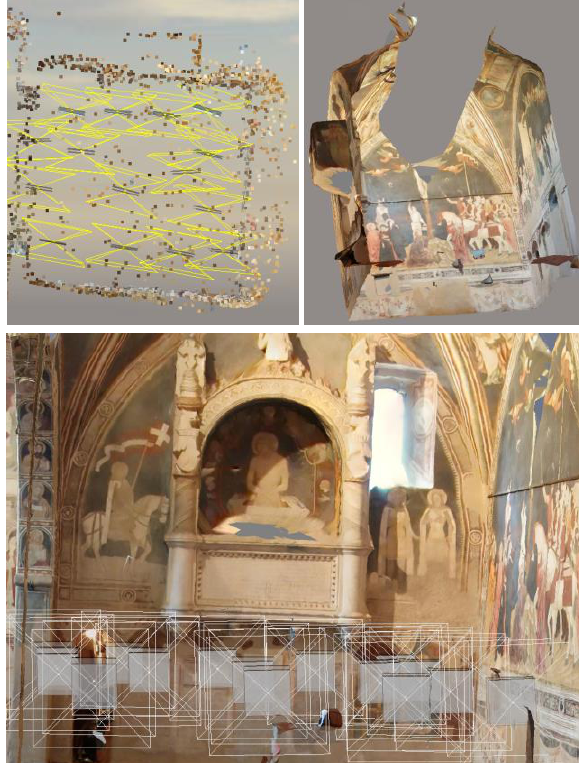
Figure 9. The reconstruction from front rear facing